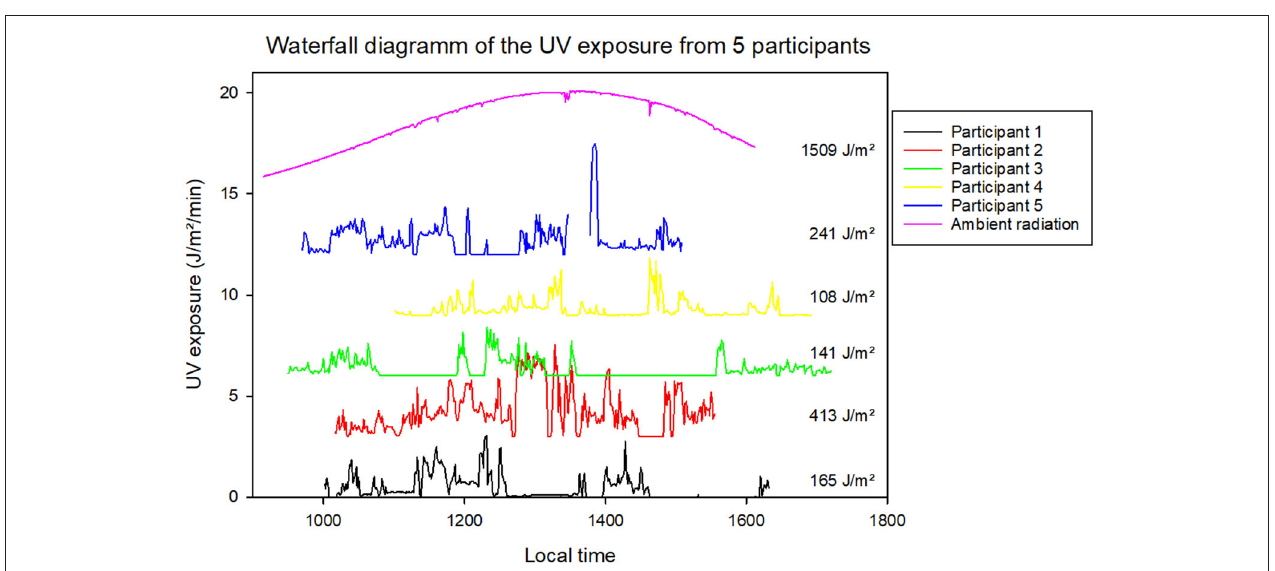
FIGURE 4 | Measurement data from five selected personal UV measurements for a single day on 17/04/2019 in comparison-related ambient radiation (in magenta). Ambient radiation was measured with a separate dosimeter placed horizontally on top of a pedestal. The measurements are displayed with offsets of 3 J/m ² /min for clarity. The total UV dose per measurement is given on the right of each